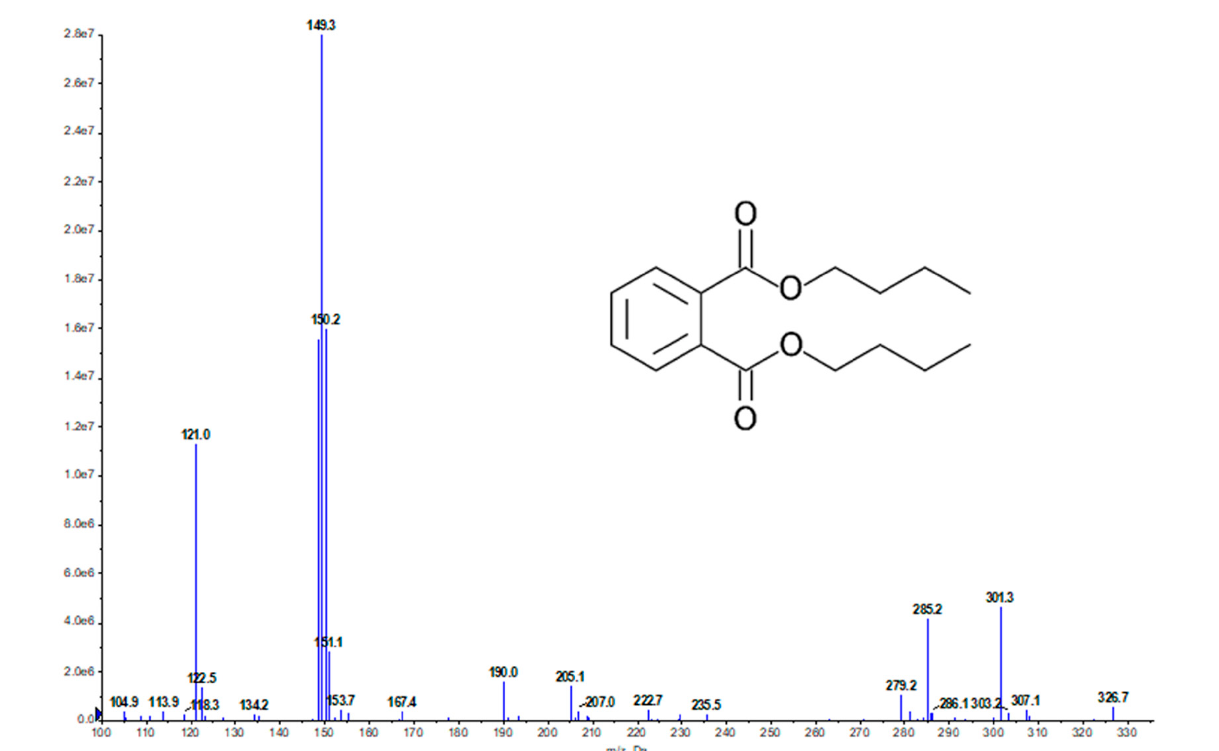
Figure 1. UPLC-MS analysis of H11809-CCF8. Selected column chromatography fractions of H11809 chloroform extracts were tested against Pf 3D7 for antimalarial activity (H11809-CCF5 to -CCF9). H11809-CCF8 (DBP was identified from this fraction) only showed antimalarial activity at high concentrations (500 µg/mL). Meanwhile, H11809-CCF9 exerted more significant activity, by which the antimalarial activity was still observed at 5 µg/mL (Table 2).